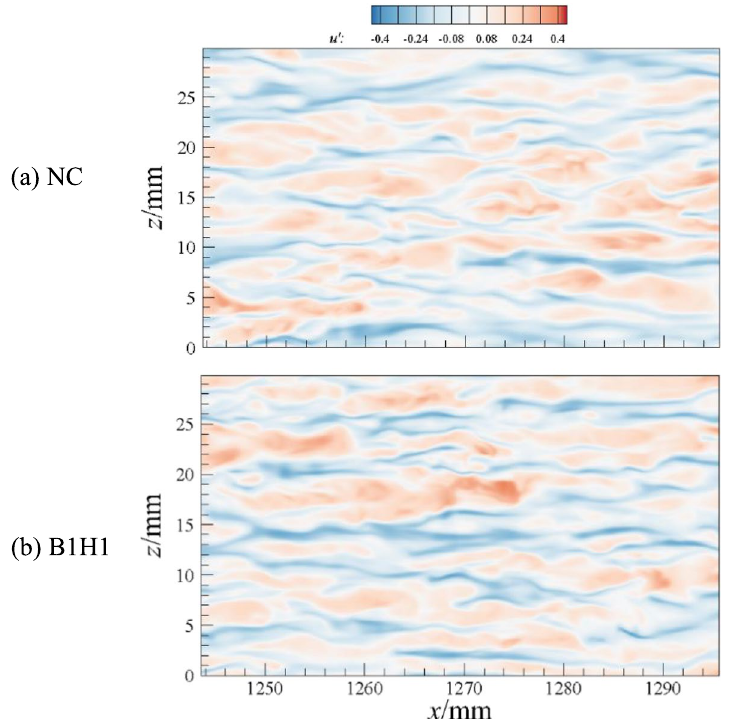
Fig. 16 Instantaneous streamwise velocity fields in wall-parallel plane at y + for -0.4 u ′ 0.4) ≤ ≤